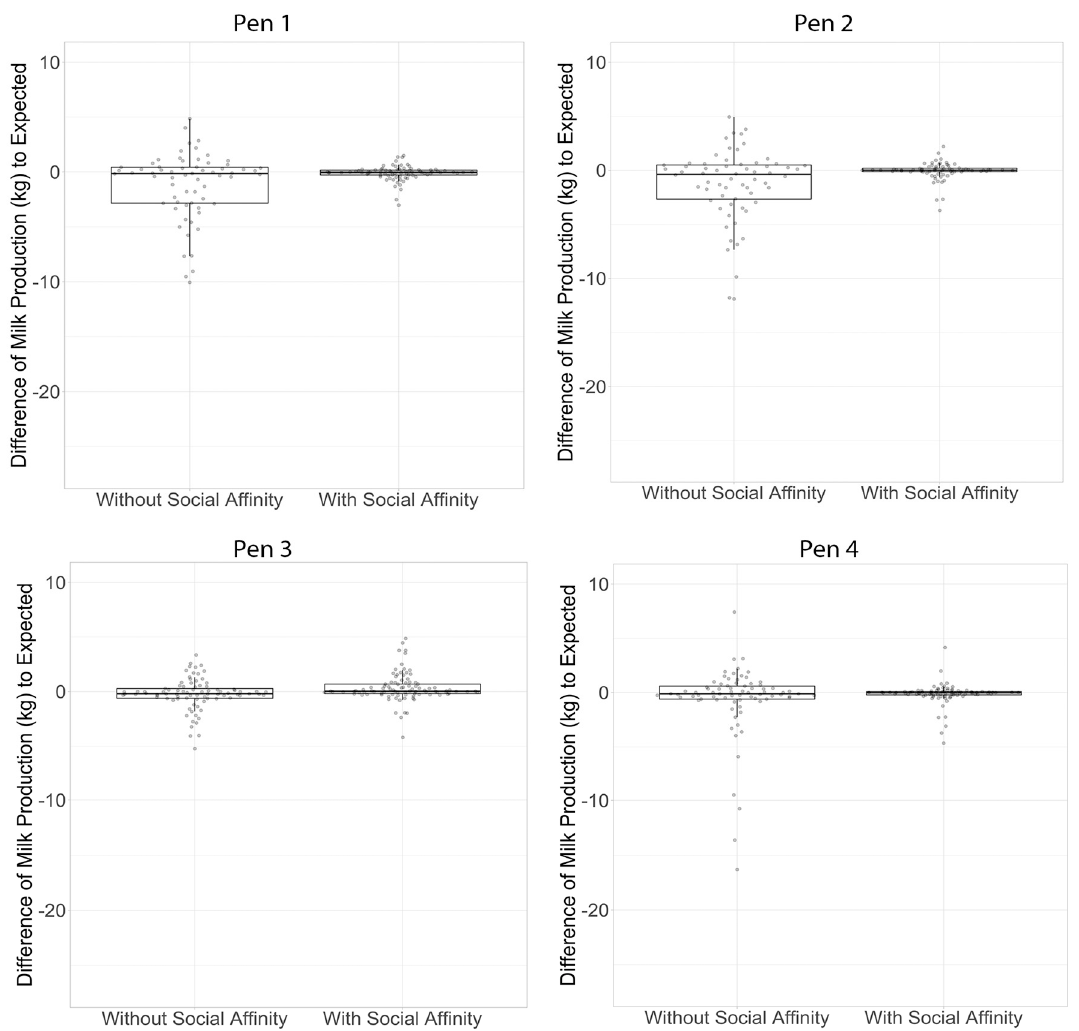
Figure 3. Difference of milk production by pen between cows during period with social affinity and periods without social